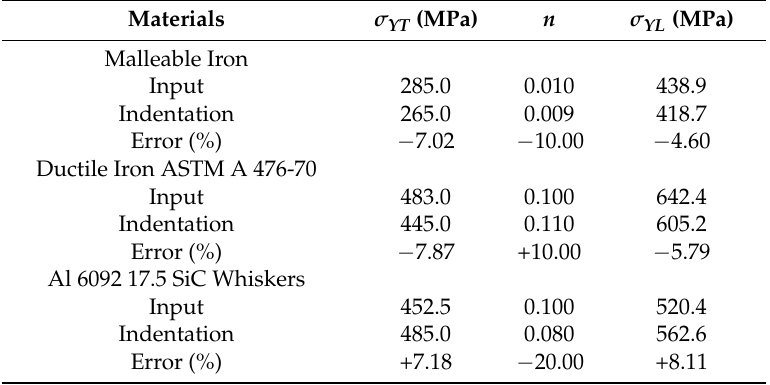
Table 6. Comparison of the anisotropic parameters between FE “Input” amounts with those obtained from inverse analysis and dual indentation